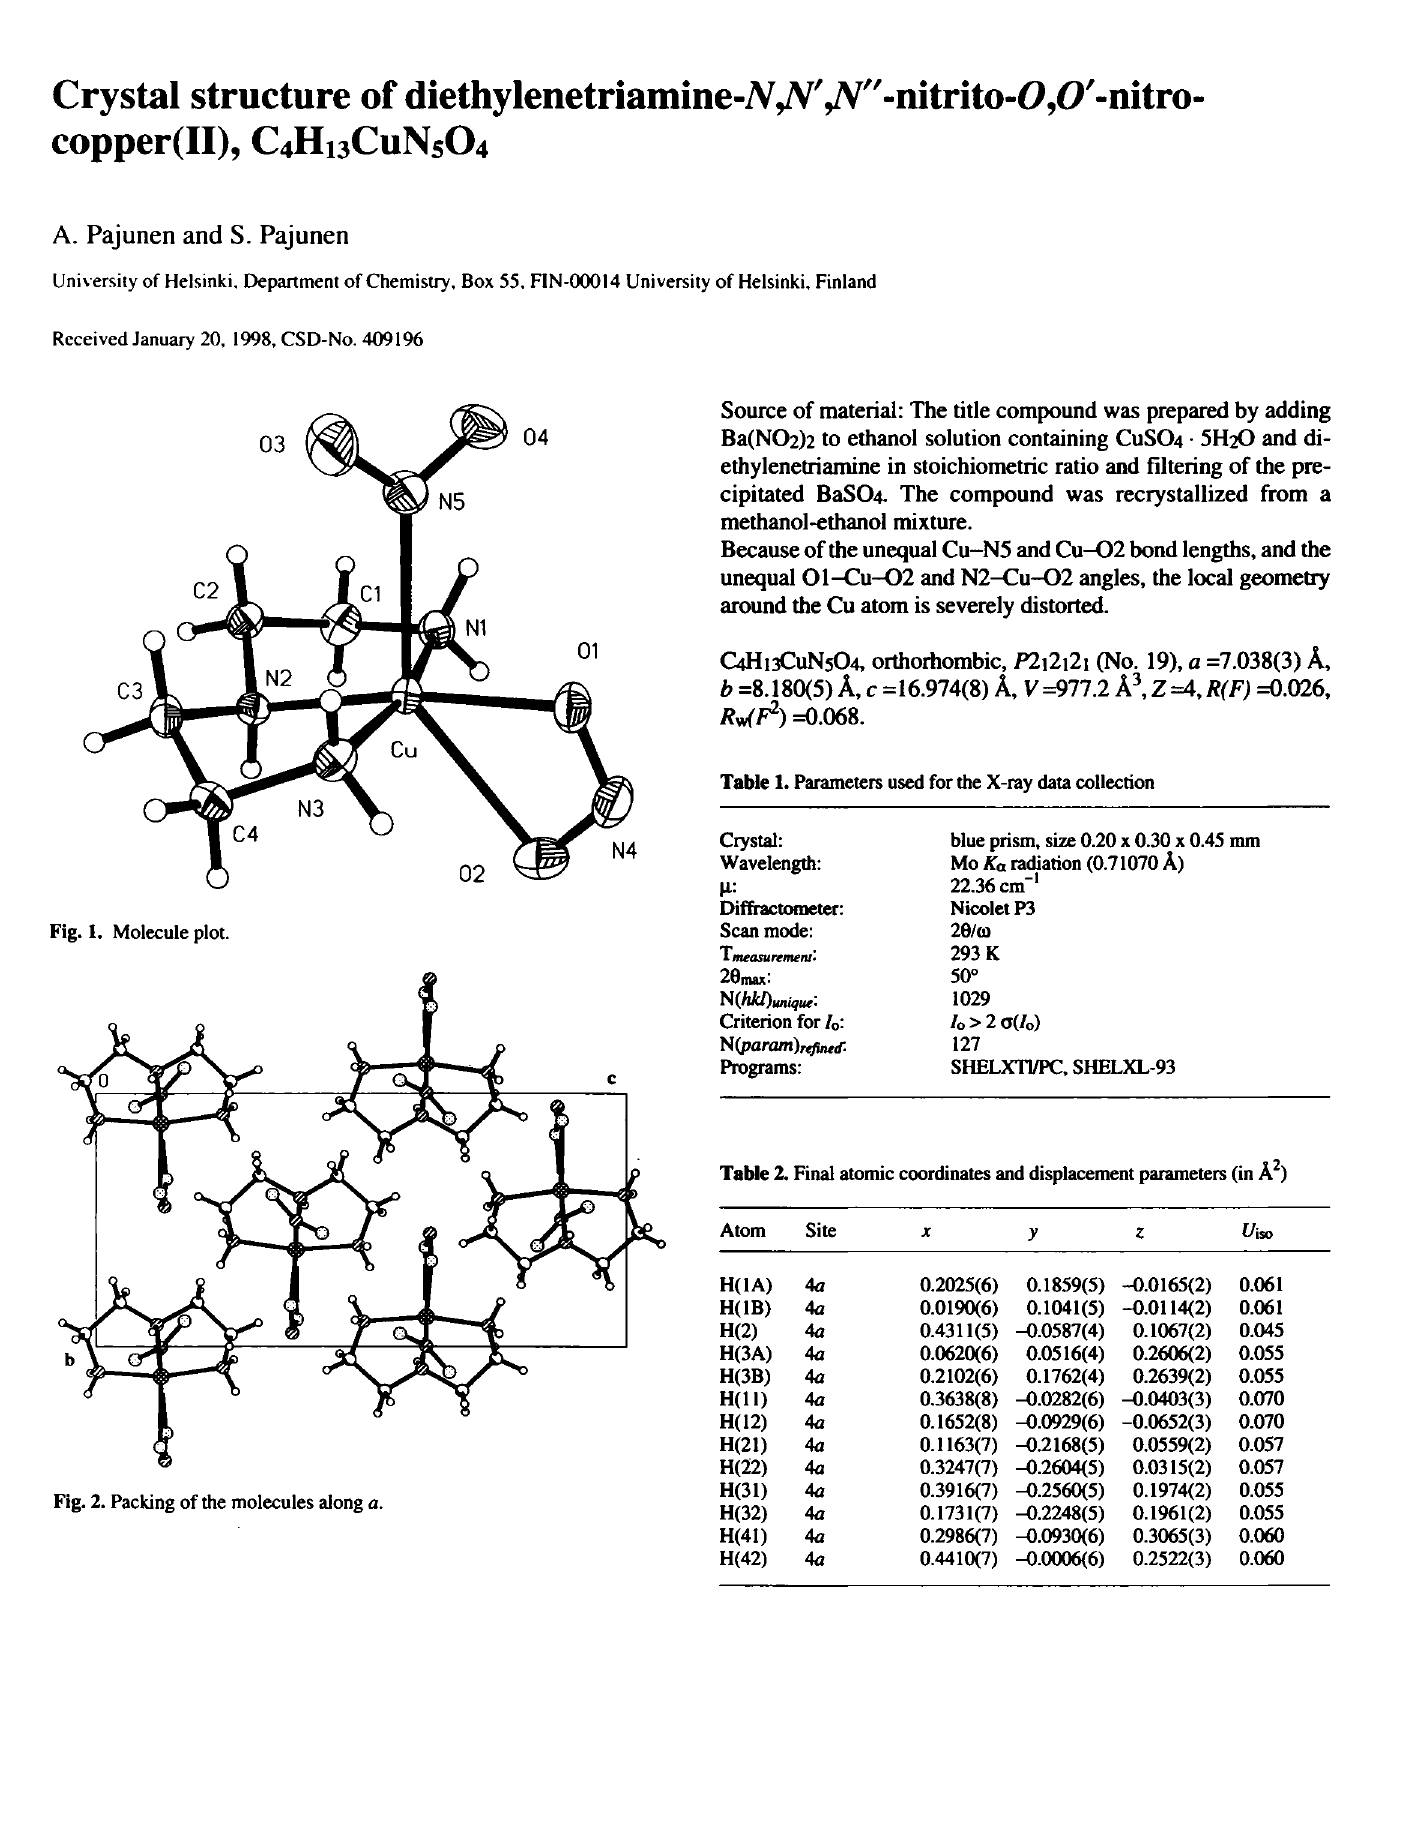
Table 2. Final atomic coordinates and displacement parameters (in